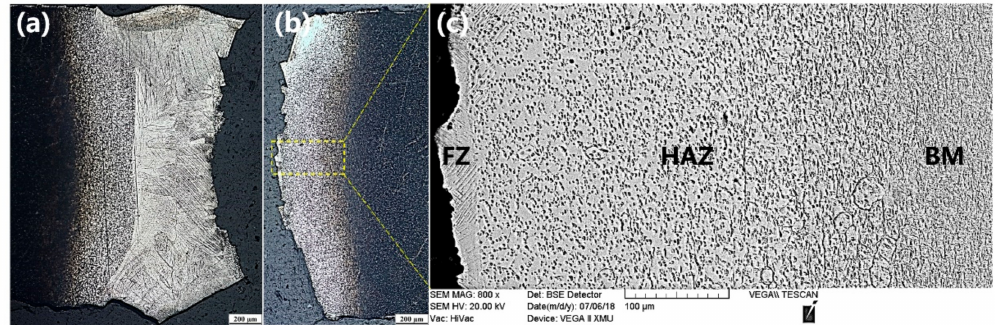
Figure 7. Fractured location of as-welded 19# joint ( a , b ) and corresponding macrostructure displayed in ( c ).